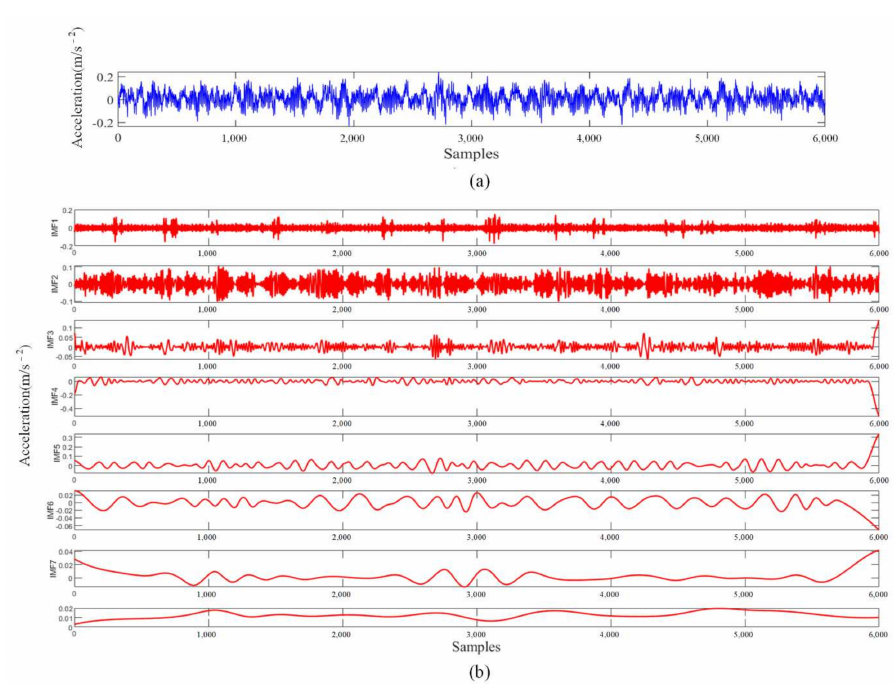
Figure 4. ( a ) the original fault signals and ( b ) the first 8 IMF components after